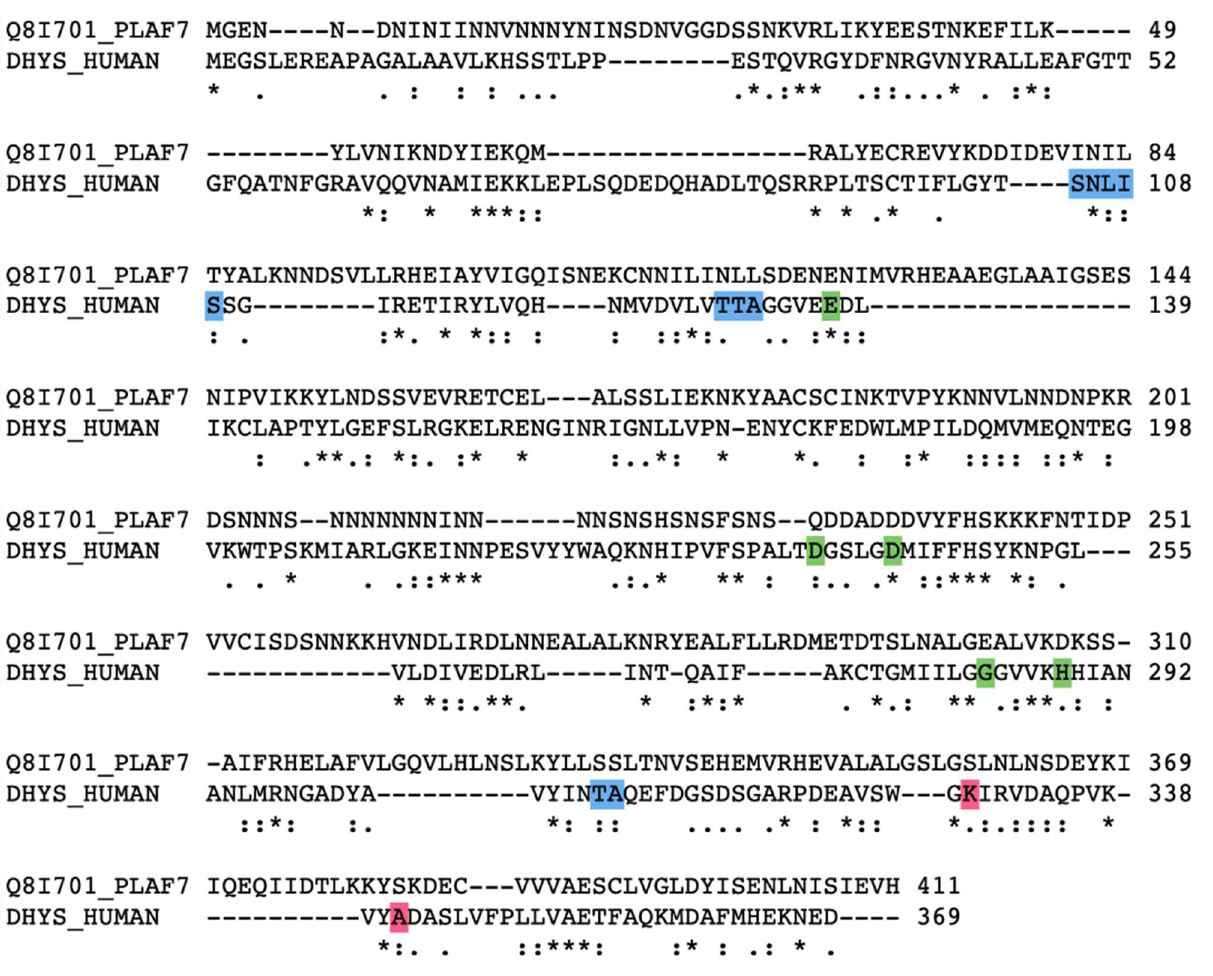
Figure 5. Amino acid alignment of P. falciparum DHS (first lane) and the human orthologue (second lane) performed with the Clustal Omega alignment tool. Gaps (-) were introduced to obtain maximum alignment. Asterisks label amino acid identities, colons (:) and dots (.) label amino acid similarities. Amino Acids marked in blue represent nucleotide binding sites in human DHS. Possible ligand binding sites are colored in green. Lys328 and Ala351 are part of the active site and shown in red color.